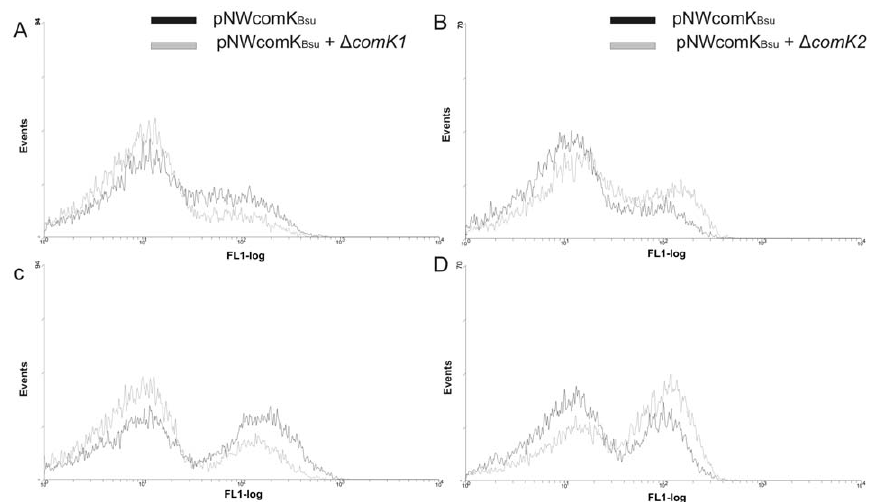
Figure 4. Single cell analyses of PcomGA-gfp and in liquid minimal medium. The effect of ComK Bsu overexpression in the wild type (black) and in the comK1 (A,C) or comK2 (B,D) mutant (gray). The samples were analyzed in three hours after IPTG induction; panels A,B- strains without induction, panels C,D- strains after induction with IPTG. The numbers of cells are indicated on the y axis, and their relative fluorescence levels are indicated on the x axis on a logarithmic scale. For each experiment at least 20,000 cells were analysed. The graphs are the representative of at least three independent experiments.